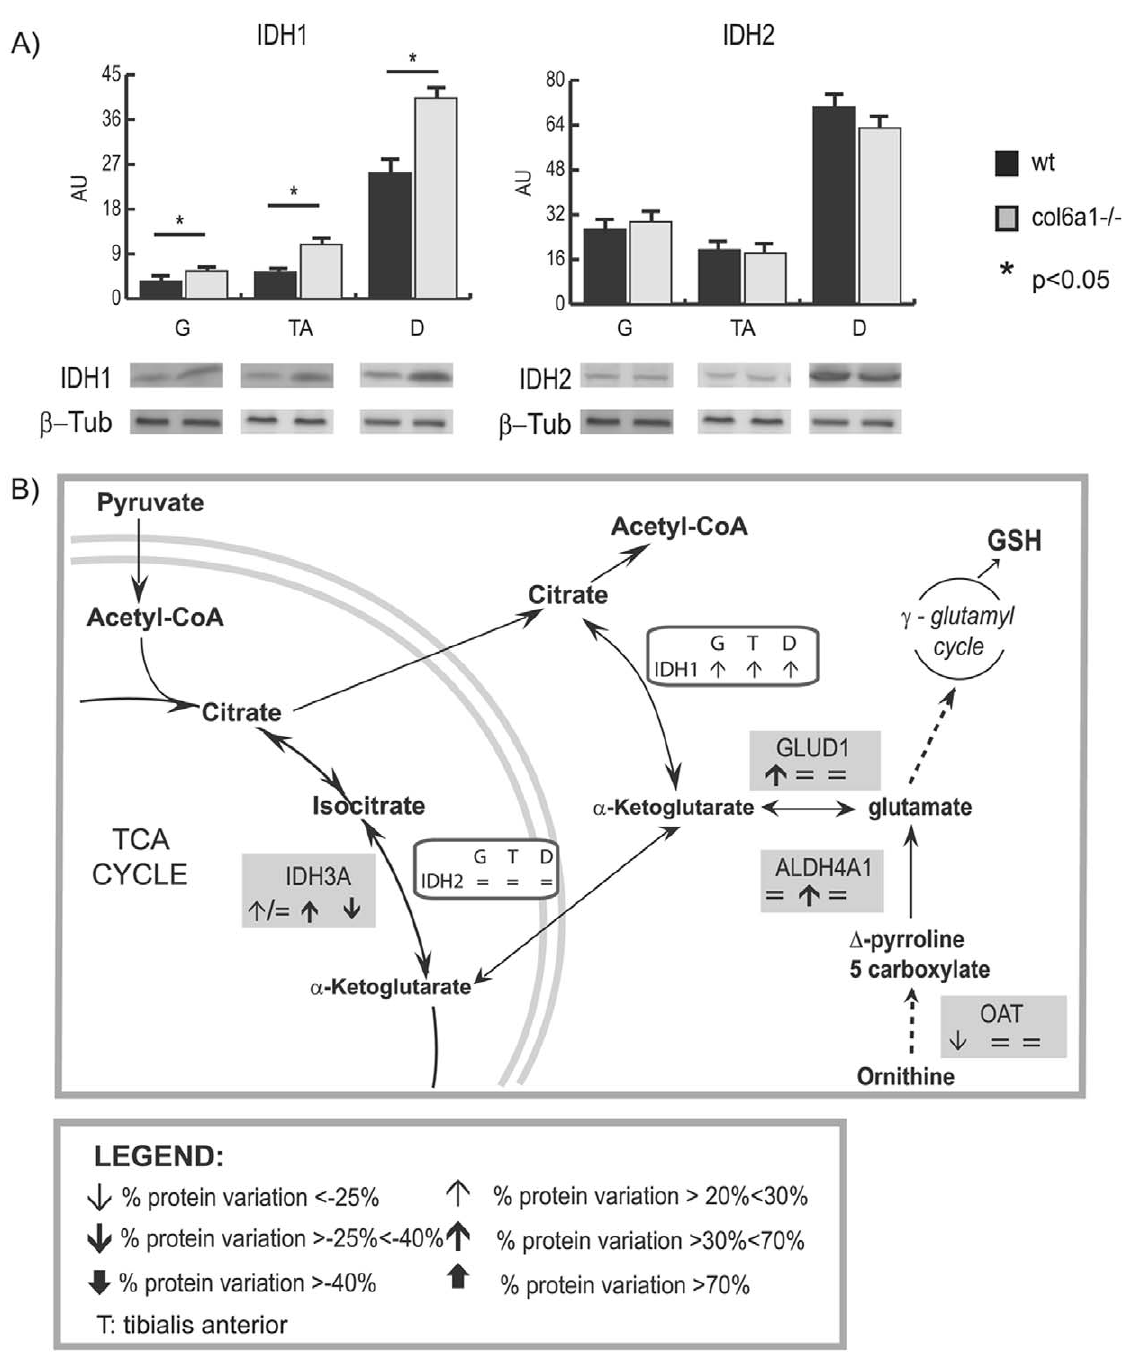
Figure 6. Immunoblotting and 2D-DIGE results on proteins involved in glutamate metabolism. Panel A: Histograms and representative immunoblot images of IDH1 and IDH2 in gastrocnemius, tibialis anterior and diaphragm from Col6a1 2 / 2 and wild-type mice (n=4; mean 6 S.D.; Student’s T-test). Panel B: schematic representation of IDHs pathways. Grey and empty rectangles contain gene names of deregulated proteins observed by 2D-DIGE and western blotting, respectively. Arrows indicate the protein trend in gastrocnemius (G), tibialis anterior (T) and diaphragm (D). For 2D-DIGE, the arrows direction indicates up- and down-regulation, the thickness the % of spot variation. =/ Q or =/ q indicate the differential expression of isoforms of the same protein in a given muscle. For western blotting, the arrows direction indicates the up- and down-regulation of relative variation of Col6a1 2 / 2 versus control wild-type muscle.